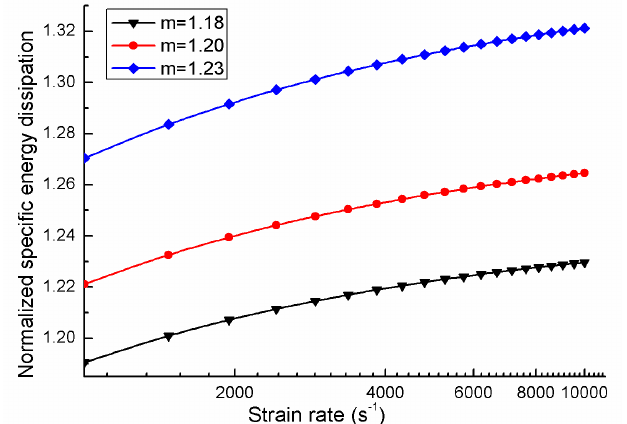
Figure 6. Logarithmic normalized specific energy dissipation with loading